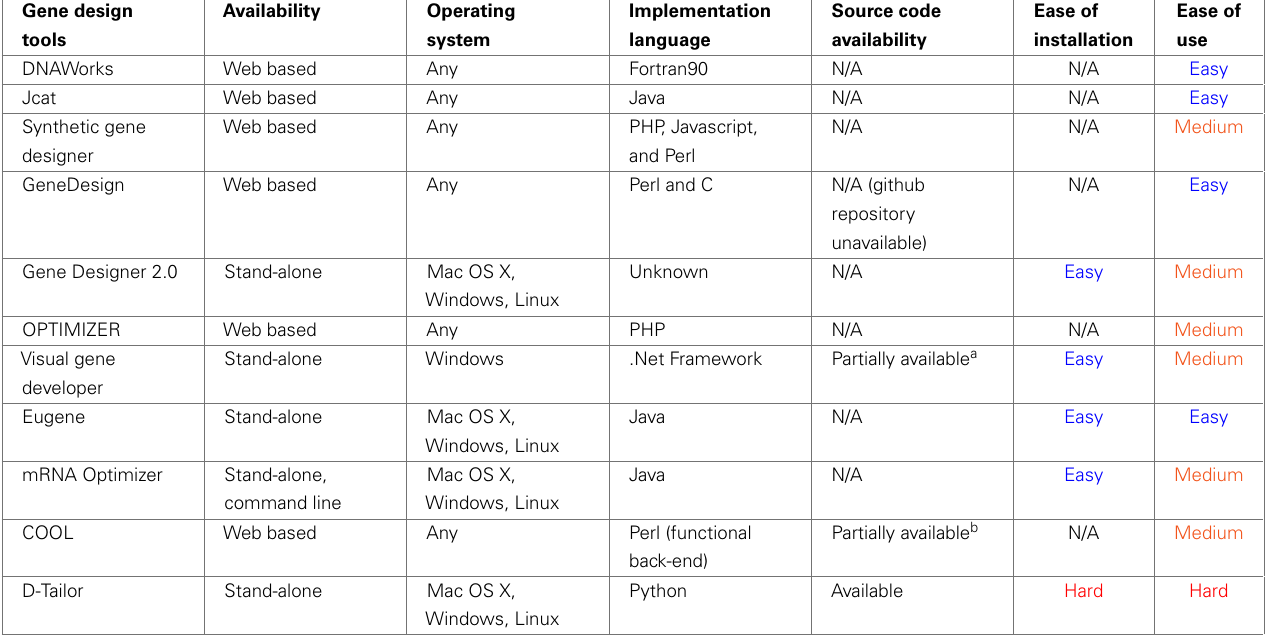
Table 3 |Availability and ease of installation/use of computational gene design tools . Gene